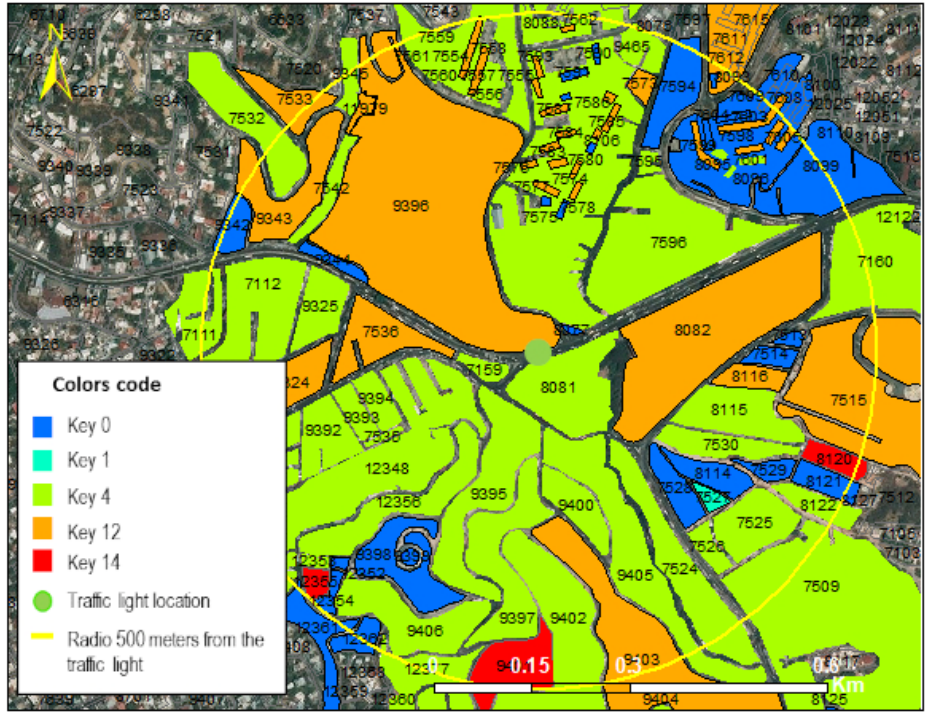
Figure 4. Traffic light “KFC–IMSS” with the selected blocks.